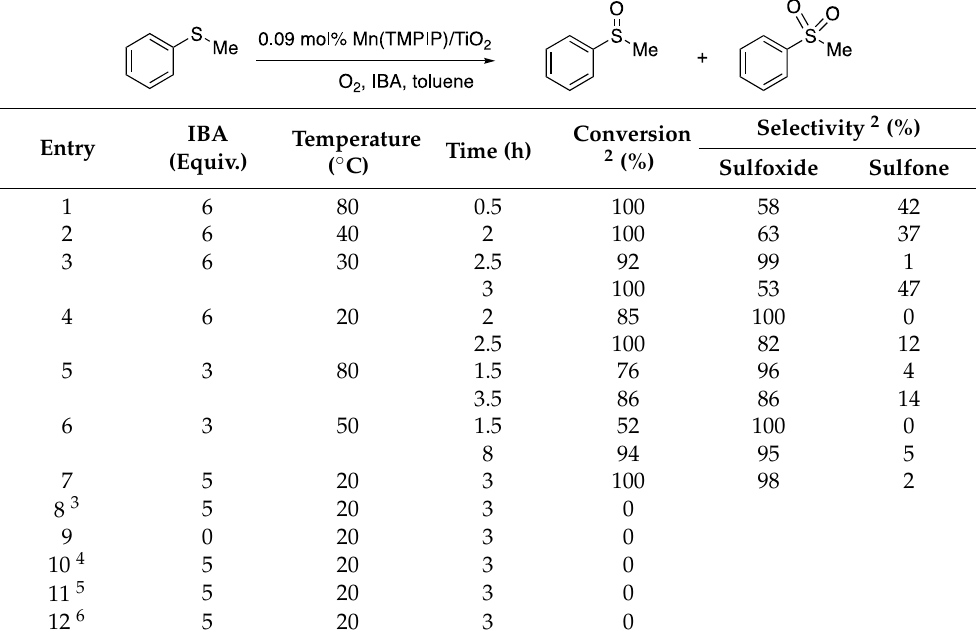
Table 1. Oxidation of thioanisole by molecular oxygen in the presence of Mn(TMPIP)/TiO 2 and IBA 1 .